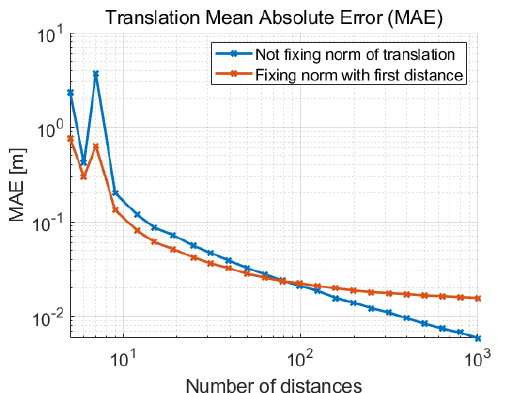
Figure 2. Mean absolute error (MAE) of the translation in 2D as a function of the number of distance measurements with standard deviation σ d = 2cm.